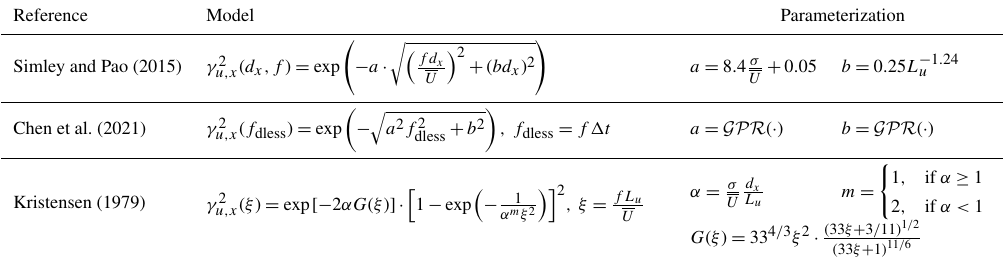
Table B1. Summary of the wind evolution models supported in evoTurb. d x is the spatial separation on the wind direction. U is the mean wind speed. σ is related to the total turbulent kinetic energy and can be calculated through of the u component. GPR ( · ) denotes a Gaussian process regression model. For brevity, the predictors (i.e., input variables) are not explicitly listed in the table. For more details, please refer to the open-access tool